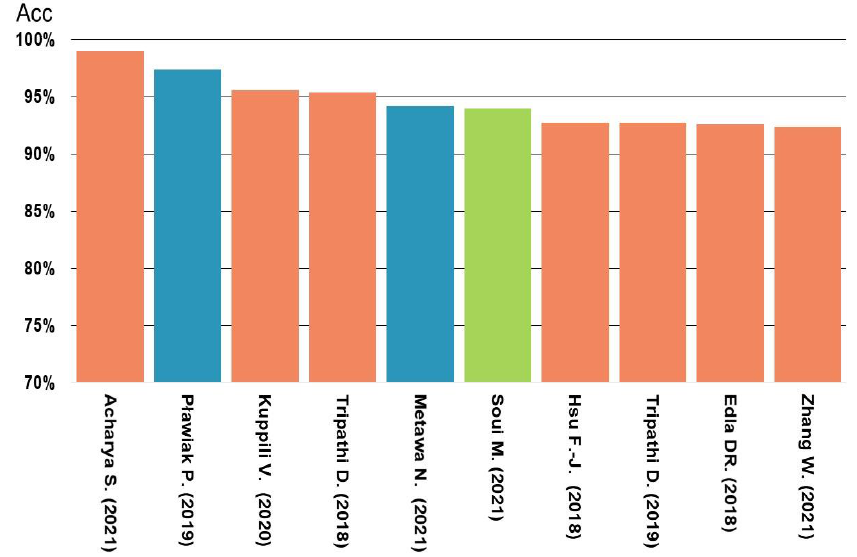
Figure 11. Comparison of accuracy of various methods for the Australian dataset [23,25,40–42,44–47,83].